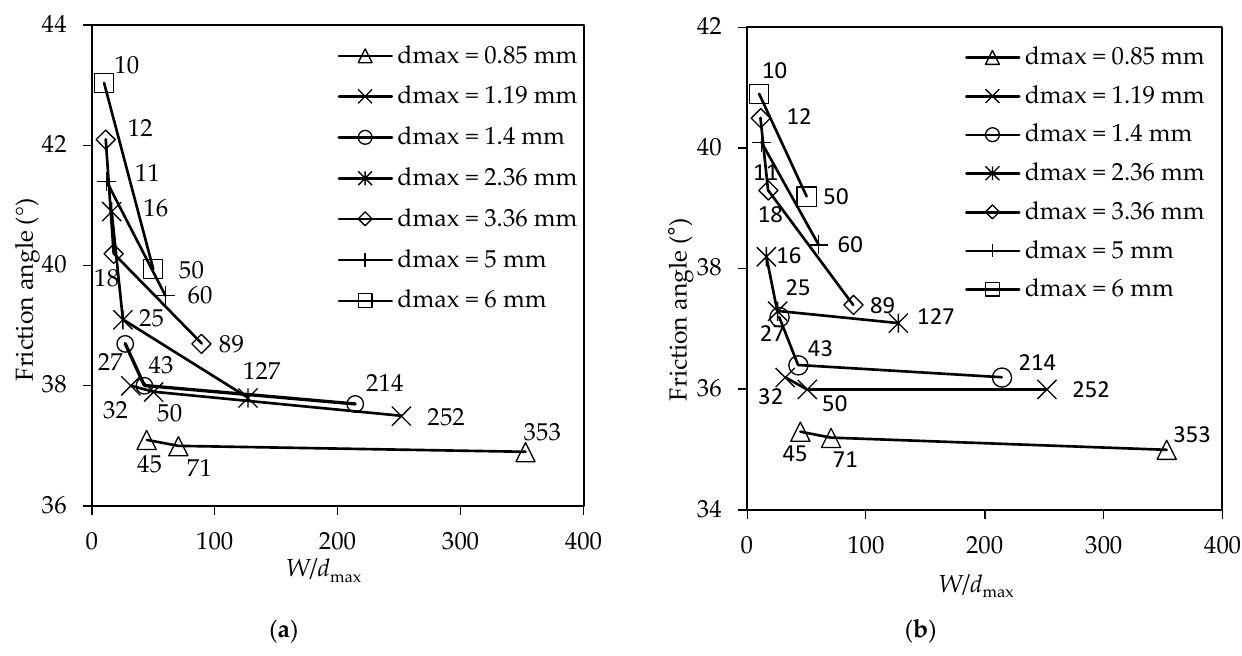
Figure 6. Variations of the friction angles of the specimens as a function of W / d max for the specimens made of ( a ) WR 1 and ( b ) WR 2.